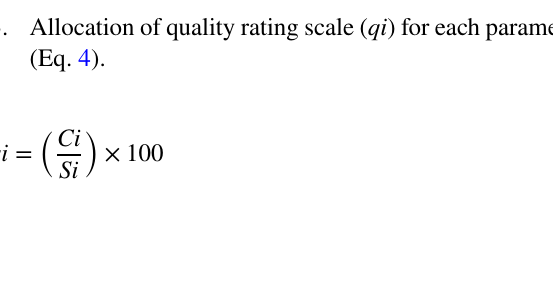
Table 1 Relative weight of groundwater parameters Parameter WHO guide- line